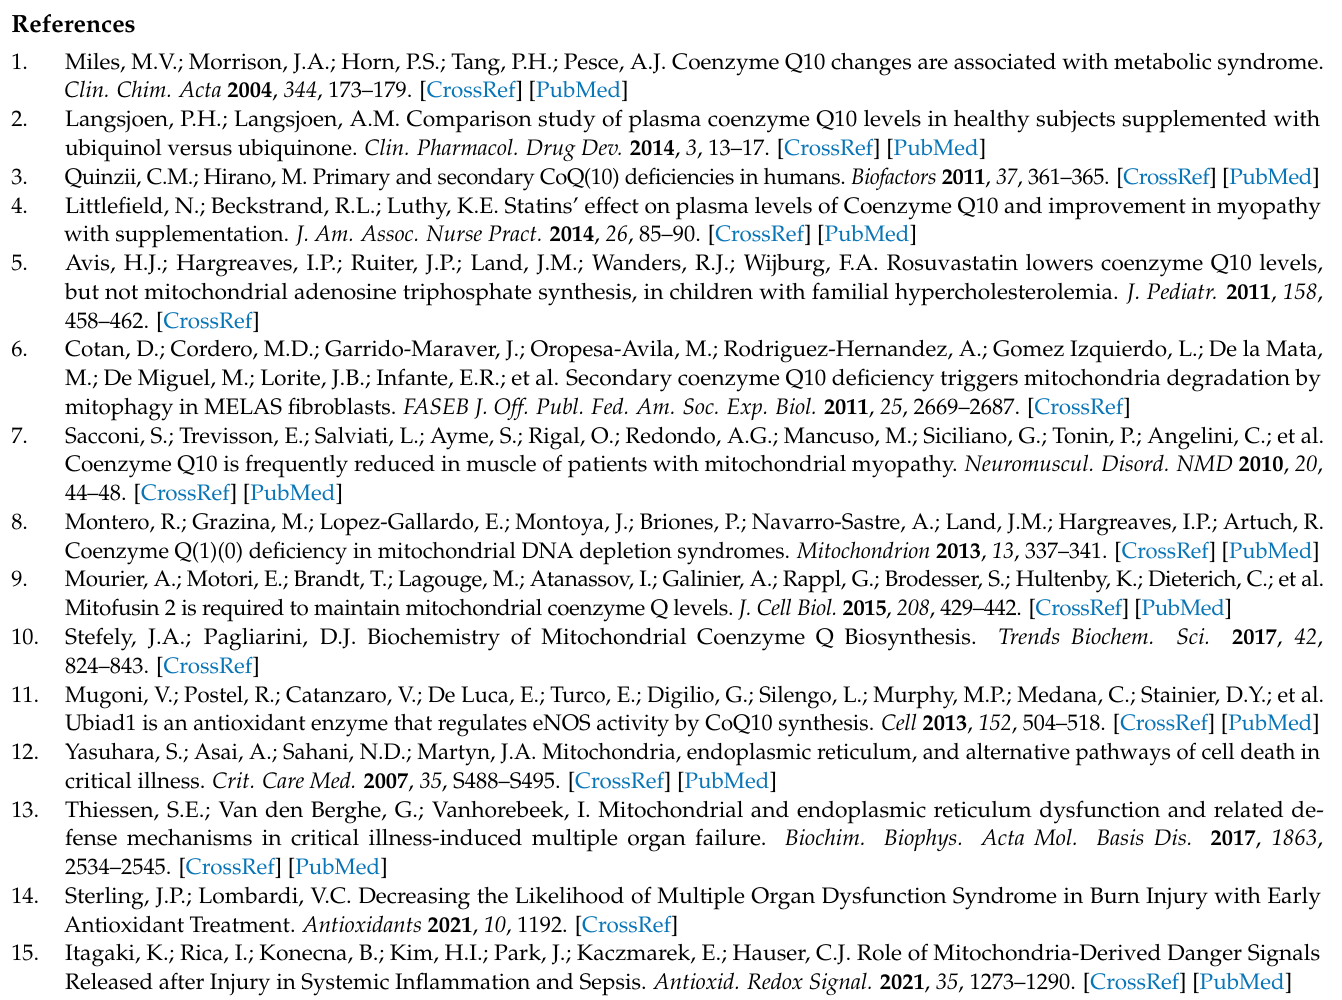
group on Day 3. Figure S4. Comparison of total CoQ10 content in PBMCS between healthy volunteers and burn patients of the CoQ10 group on Day 3 and